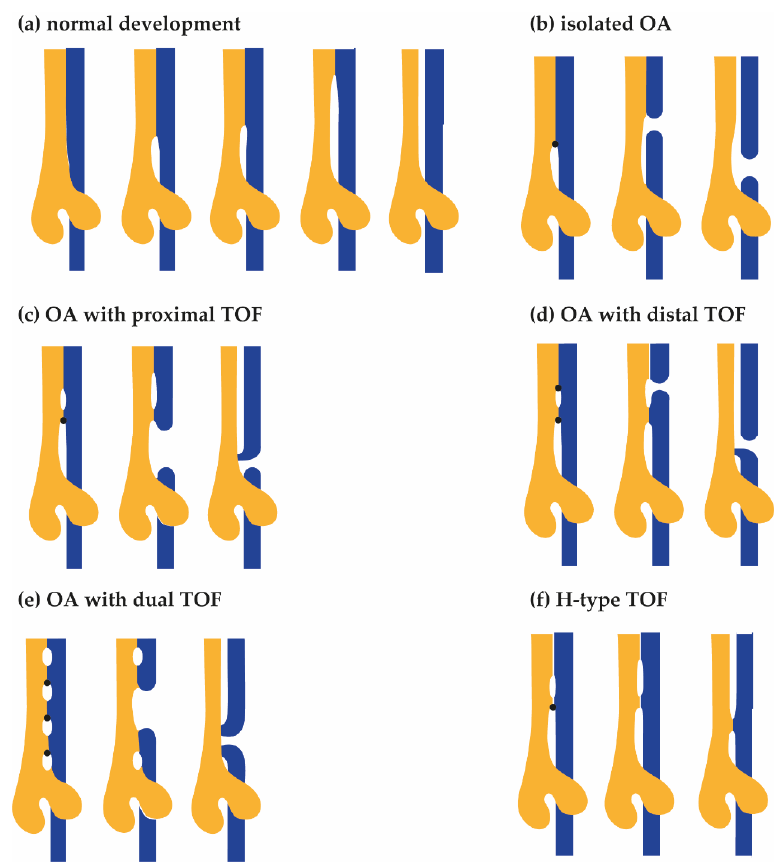
Figure 1. Hypothetical models for the development of Oesophageal Atresia (OA) and TracheoOesophageal Fistula (TOF). From left to right, advancing stages of tracheal (yellow) and oesophagus (blue) development are shown. ( a ) In the normal situation, the oesophagus and trachea fully separate. Tracheoesophageal separation starts before lung bud formation: ventral primordial tracheal (yellow) and dorsal oesophagus (blue) fields develop. Subsequently, a saddle shaped structure expands rostrally, separating the future oesophagus from the future trachea. Unidentified defects result in disturbances of the rostral expanding tracheoesophageal septum (arrow), resulting in narrowing and subsequent rupture of the future oesophagus. ( b ) Type A, isolated OA. The expansion of the first septum is blocked. The septum expands dorsally, resulting in the formation of oesophageal atresia without a fistula. ( c ) Type B, OA with proximal TOF. The expansion of the first septum is blocked. A second septum forms and expands rostrally. The first septum expands dorsally, resulting in the formation of a proximal fistula and oesophageal atresia. ( d ) Type C, OA with distal TOF. The expansion of the first septum is blocked. A second septum forms and expands rostrally as well as dorsally, resulting in the formation of a distal fistula and oesophageal atresia. ( e ) OA with dual TOF. There are multiple blockage points. The middle septum expands dorsally, creating both a proximal and distal fistula as well as oesophageal atresia. ( f ) Type E, H-type fistula. The expansion of the first septum is blocked. A second septum forms and expands rostrally, resulting in the formation of a fistula. 3. Genetic Contribution to OA/TOF Aetiology The association between similar recurrent anomalies could be caused by genetic defects in one specific gene. Indeed, OA/TOF is a variable feature in more than 70 (often mono-) genetic syndromes (see Table 1). These syndromes have autosomal recessive, X- linked recessive, and autosomal dominant inheritance. However, they have a much lower prevalence compared with that of OA/TOF, and in most of these syndromes, OA/TOF is a variable characteristic that is not frequently present [24,25]. Mutations in DNA repair